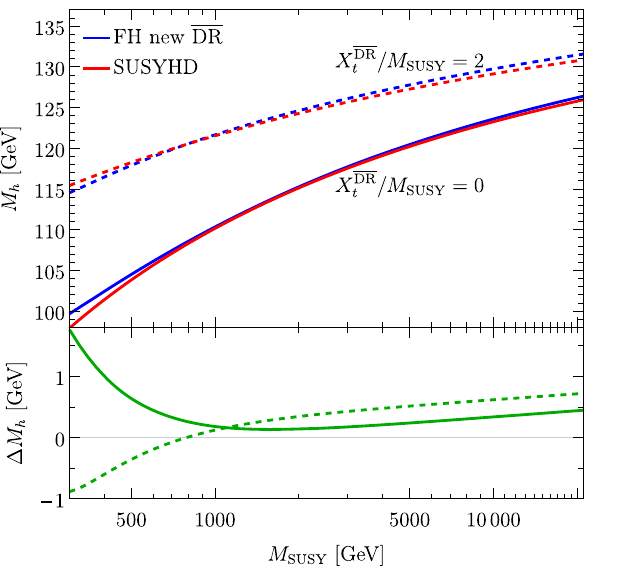
and M SUSY = 20TeV(dot-dashed).Inthebottompanels,thedifference between the blue and red curves is shown ( Δ M h = M h ( FH new DR ) − M h ( SUSYHD )